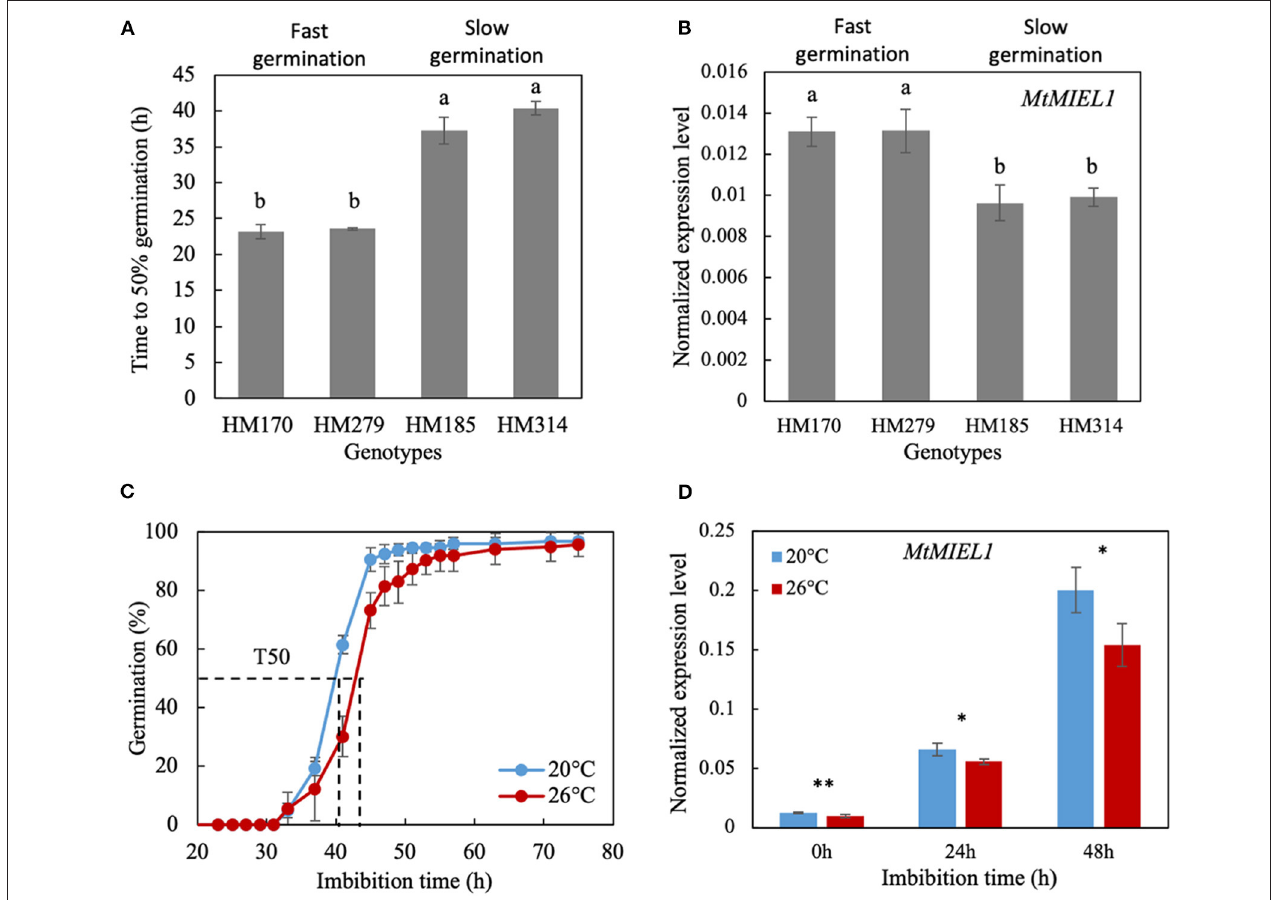
FIGURE 4 | Characterization of seed germination and MtMIEL1 expression in Medicago truncatula seeds. (A) Germination speed (T50) at 15 ◦ C of seeds produced under heat stress condition (26 ◦ C) of four natural M. truncatula HapMap accessions. (B) Expression level of MtMIEL1 in dry, mature seeds produced under heat stress condition (26 ◦ C) of the four natural M. truncatula HapMap accessions. Different letters indicate significant differences ( P < 0.05) identifying by ANOVA and Tukey’s honest significant difference (HSD) test. (C) Germination curves at 10 ◦ C of M. truncatula reference genotype A17 seeds produced at 20 ◦ C and 26 ◦ C. The dash lines indicate the time to reach 50% germination (T50) of 20 and 26 ◦ C seeds. (D) Expression levels of MtMIEL1 in dry, mature seeds (0h), 24-h imbibed seeds (24h), and 48-h imbibed seeds (48h) which were produced at 20 and 26 ◦ C. *, 0.01 < p -value < 0.05; **, 0.001 < p -value <